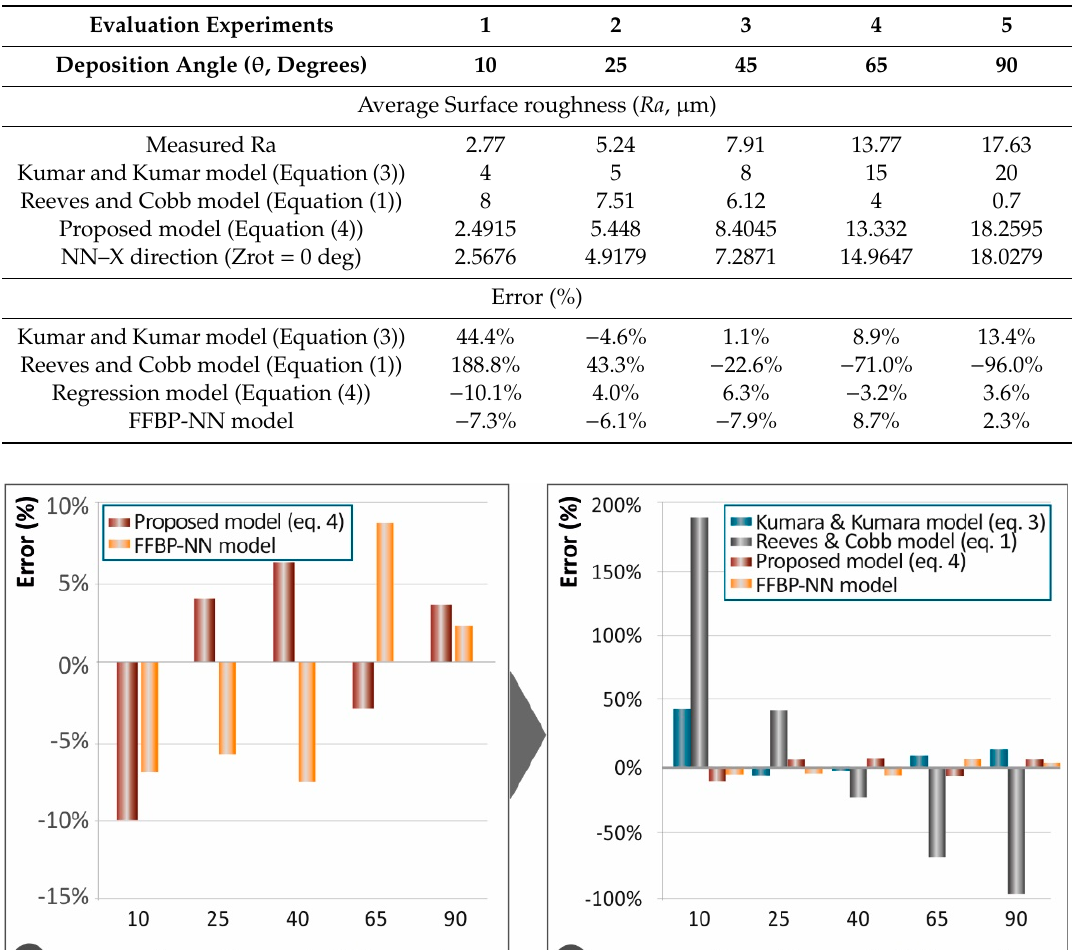
Table 3. Comparison of Ra predictive models.